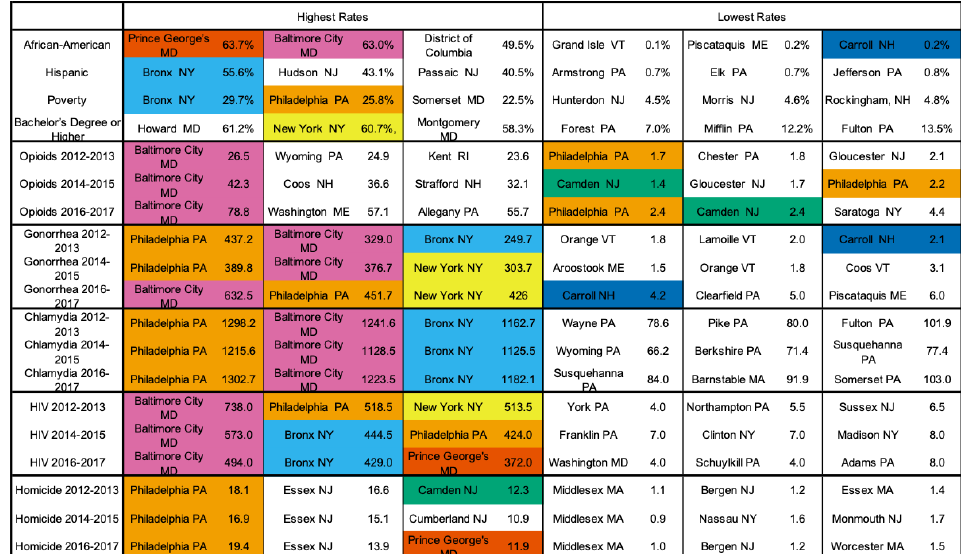
Figure A7. The distributions of county values of each of the response variables used in the model separated by year group. Red represents 2012–2013, orange represents 2014–2015, and blue represents 2016–2017.